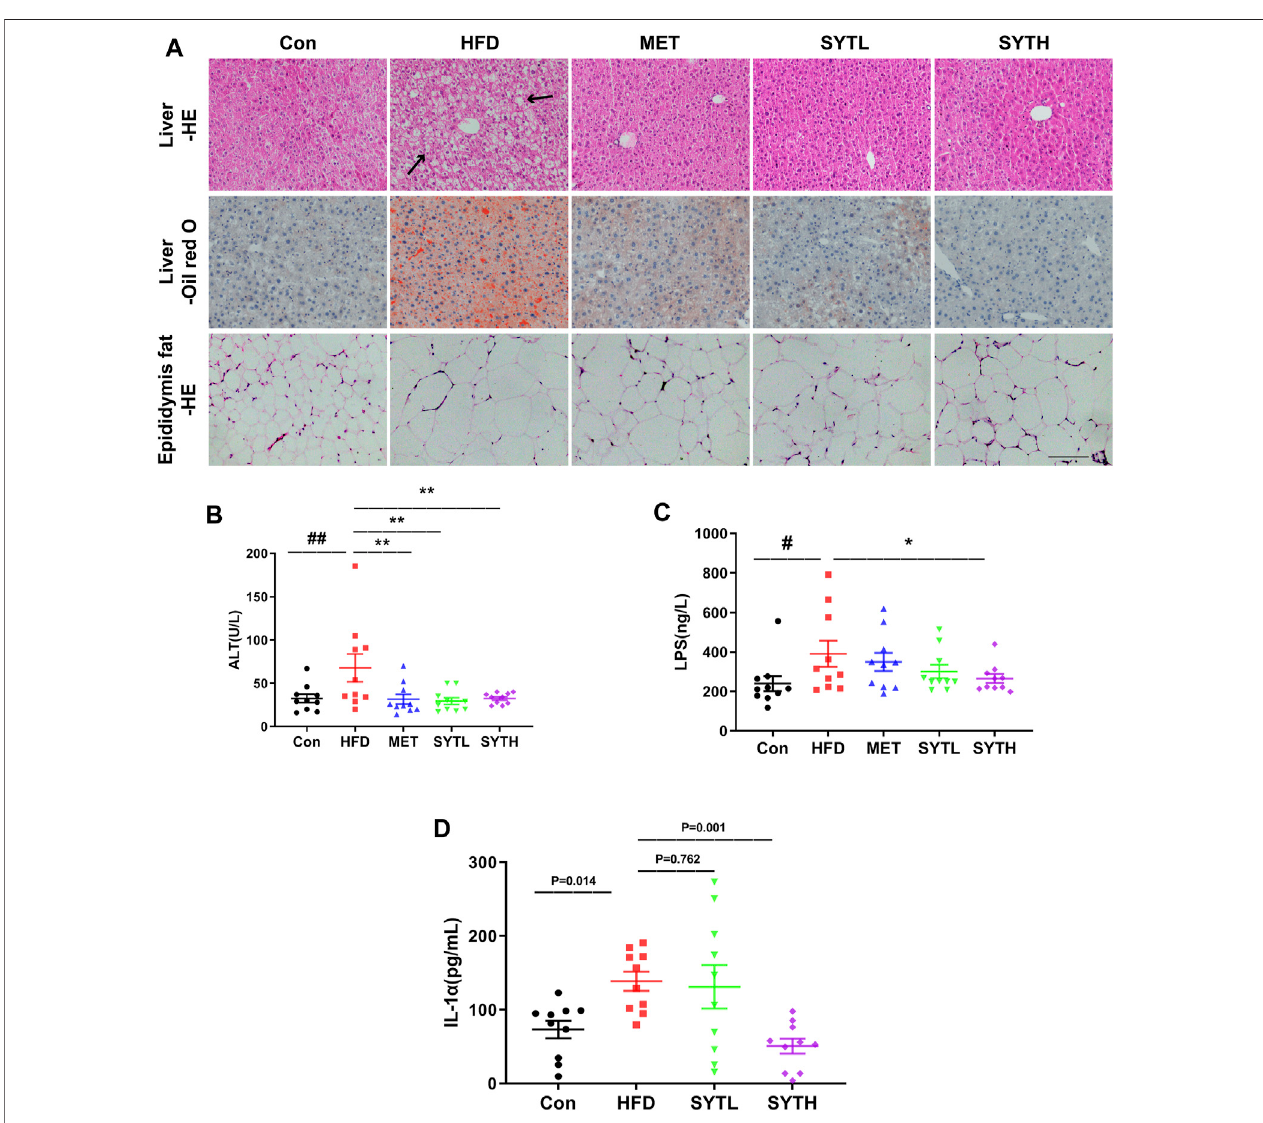
FIGURE 4 | SYT alleviates hepatic steatosis and reduces circulatory in fl ammatory cytokines in HFD mice. After treatment with SYT for 20 weeks, serum samples, livertissues,andepididymalfatwereobtainedfromallthemice.Liverandepididymal fattissueswerestainedwithHE.LivertissuewasstainedwithoilredO.Scalebar (cid:2) 200 μ m (A) .ThelevelsofserumALT (B) ,LPS (C) ,andIL-1 α (D) weremeasured. # p < 0.05, ## p < 0.01comparedwithCongroup;* p < 0.05, ** p < 0.01comparedwiththe HFD